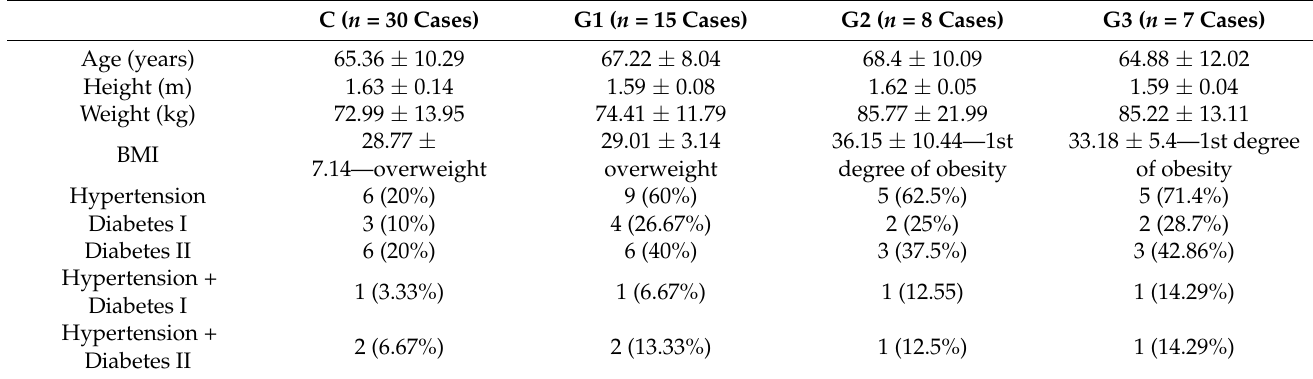
Table 2. Characteristic of patients included in a control group and a study